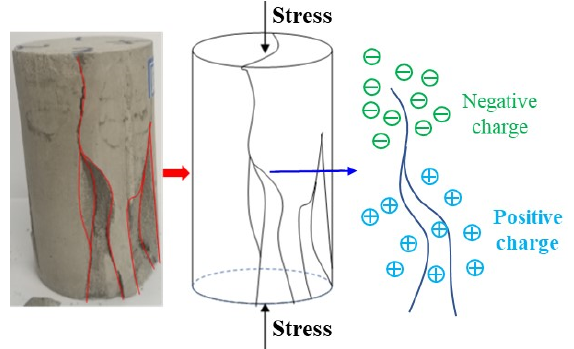
Figure 15. Schematic diagram of friction effect in concrete failure process.